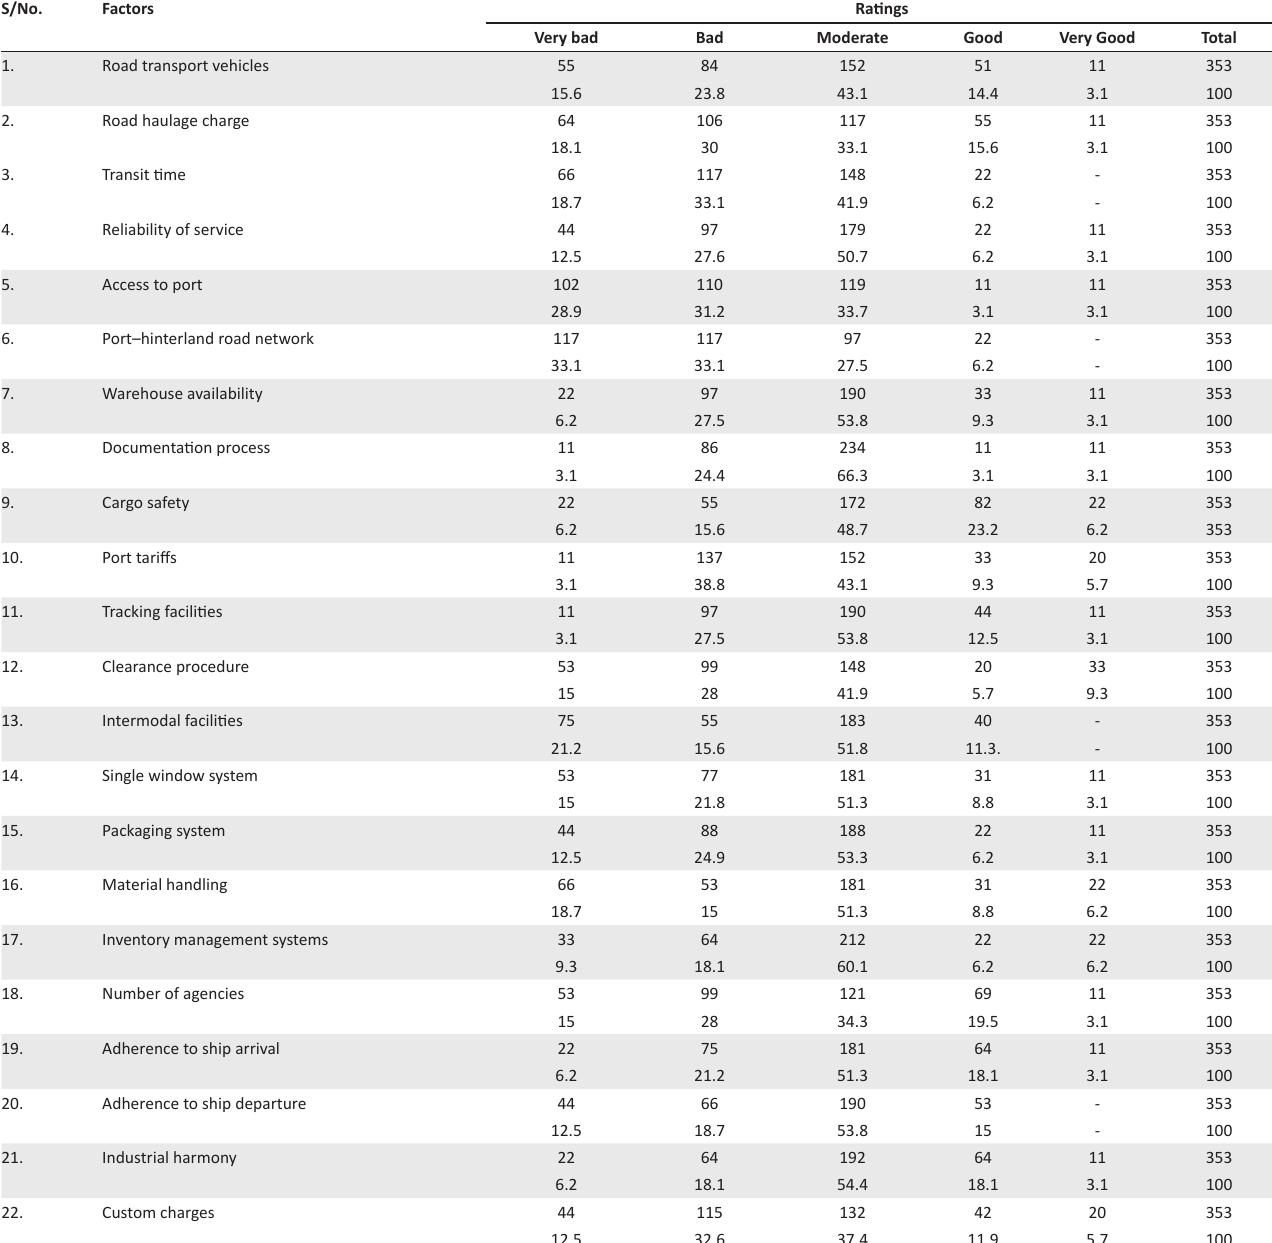
TABLE 3: Respondents’ responses on trade logistics and supply chain elements.